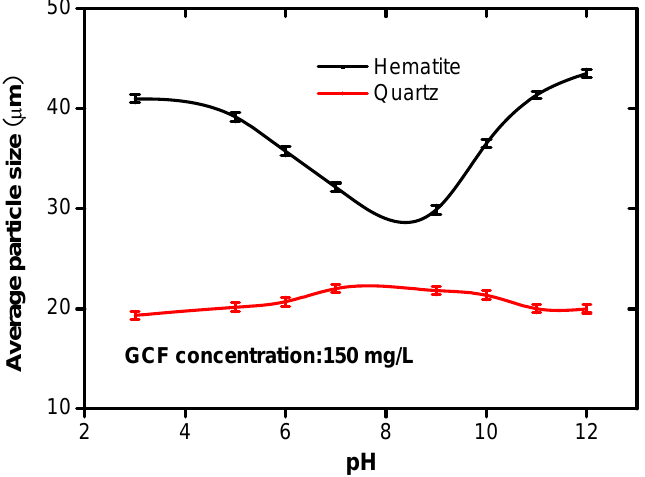
Figure 6. Effect of pH on the average mineral floc sizes using GCF as a flocculant.